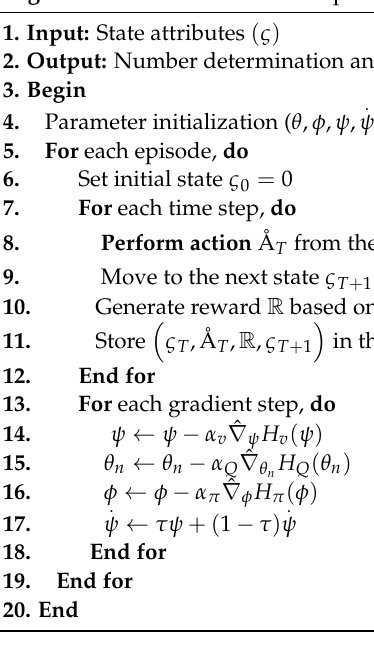
Algorithm 3 DPSAC ‐ based UAV positioning.